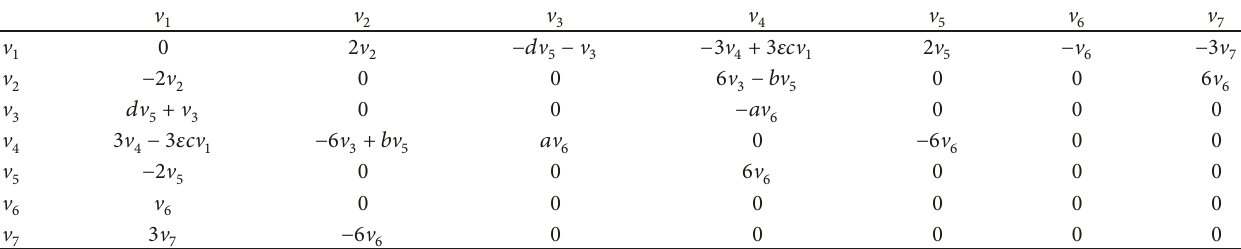
Table 1: Approximate commutators of approximate symmetry algebra of (1) ( 𝑎 = 2𝛼 − 𝛽 , 𝑏 = 2𝛽 − 𝛼 , 𝑐 = 𝛼 + 𝛽 , 𝑑 = 3𝛼/2 ).